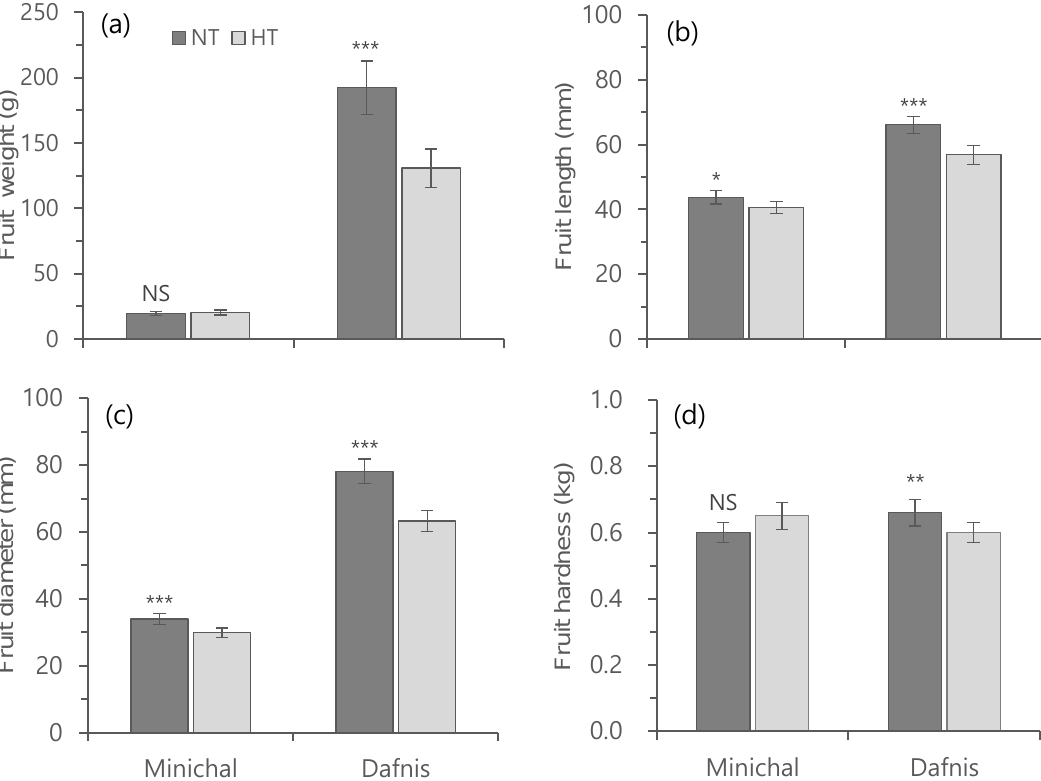
Figure 10. The fruit weight ( a ), fruit length ( b ), fruit diameter, ( c ) and fruit hardness ( d ) of tomatoes in normal (NT) and high temperature (HT) greenhouses. Vertical bars represent ± SD (n = 10). NS, *, ** and *** indicate not significant and significant at the p ≤ 0.05, p ≤ 0.01, and p ≤ 0.001 levels in t -test, respectively.